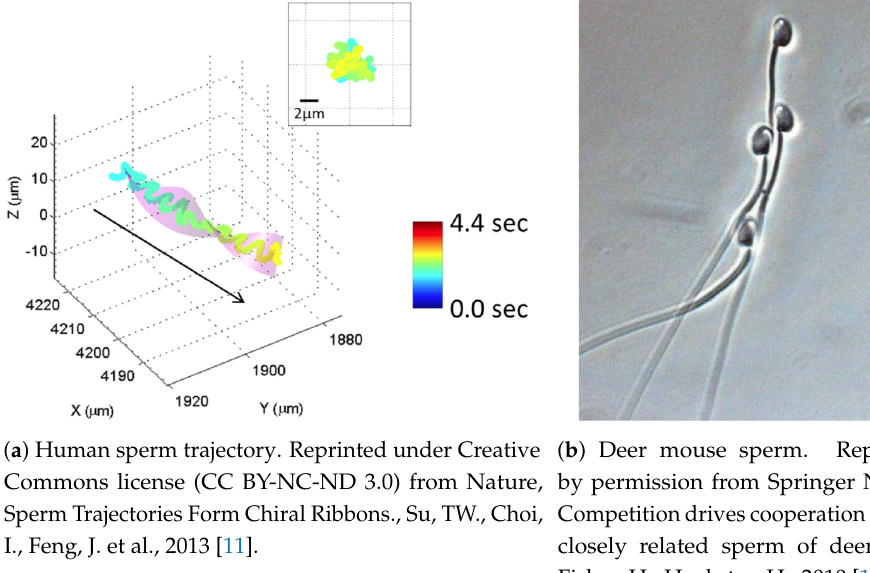
Figure 1. Images taken from experimental work with sperm swimming in populations. In panel ( a ), a trajectory of a single human sperm swimming in a population of sperm. The trajectory twists over time, creating a chiral ribbon. Arrow denotes progressive motion of sperm and inset shows a front view of the trajectory. In panel ( b ), sperm from deer mouse form a sperm train using apical hooks on sperm heads to loop around other flagella. This is one type of collective or cooperative behavior observed in